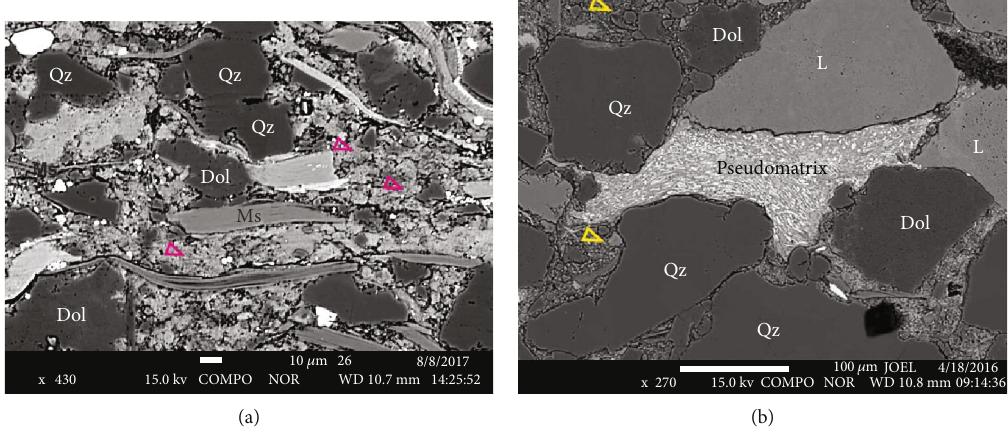
Figure 5: SEM-BSE images showing sedimentary components in matrix-rich sandstones. (a) Calcite matrix (pink arrows) occurs only in the sandstones of the Endr ő d Formation, well M7, 5471m, Endr ő d Fm. (b) Pseudomatrix and siliciclastic matrix (yellow arrows) among detrital grains in sandstones of the lower turbidite system, well M7, 3410 m, Szolnok Fm. Abbreviations: L: carbonate rock fragment; Dol: dolomite; Ms: muscovite; Qz: